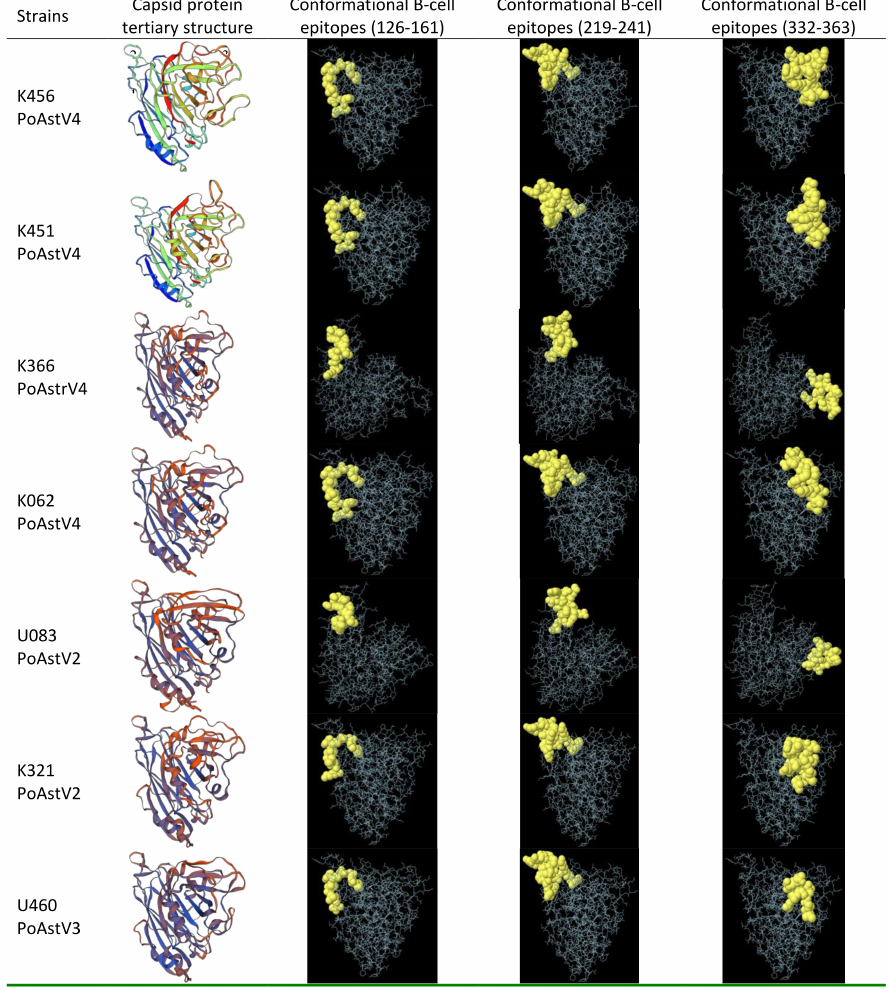
Figure 4. Capsid protein structures and conformational B-cell epitopes of PoAstV protein predicted by Ellipro from 3D structure template. Yellow balls are the residues of predicted peptides and white sticks are the non-epitope residues of protein. Each epitope is predicted with residue number and position